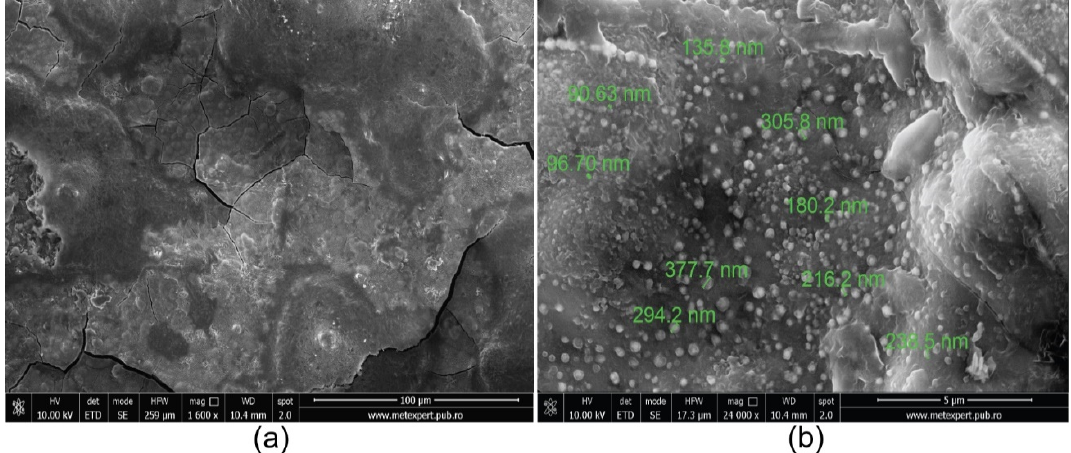
Figure 3. SEM morphology of the CoCrFeMnNi film electrodeposited at −2.1 V for 60 min: ( a ) ×1600; ( b ) ×24000.